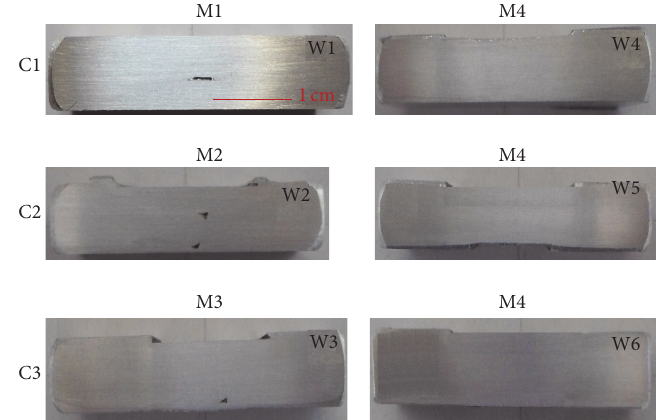
Figure 6: Tunnel defect for welding specimens using different pin profiles, for three tool rotating speeds and two welding speeds.